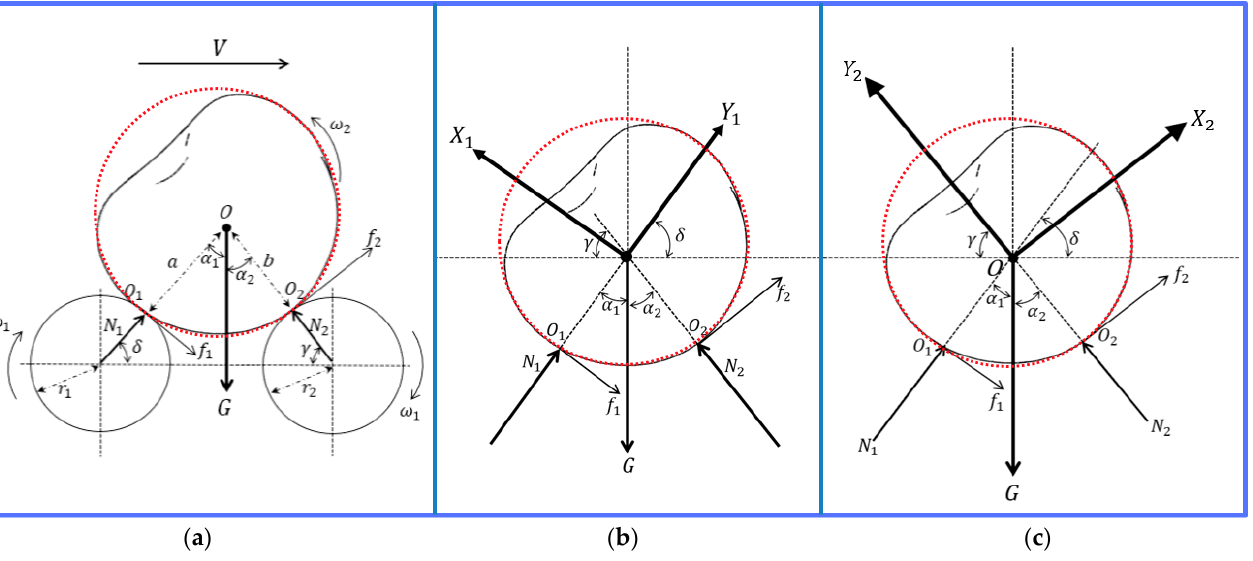
Figure 10. The force analysis of sweet cherry and double-roller supporter: ( a ) location diagram; ( b ) force diagram of O 1 ; and ( c ) force diagram of O 2